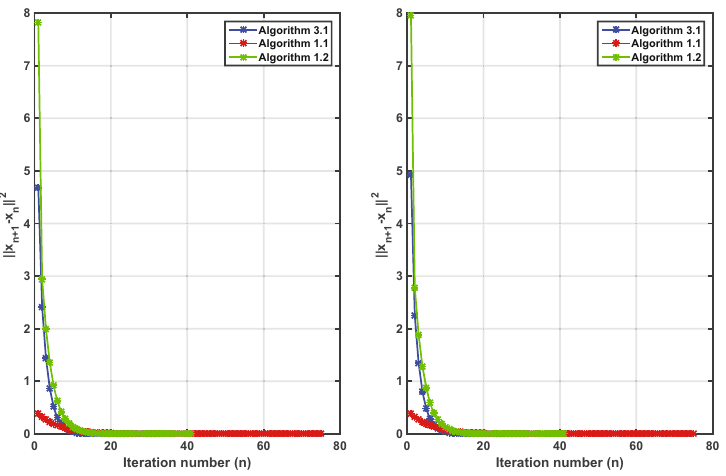
Figure 4: Problem 1, left: Case I; right: Case